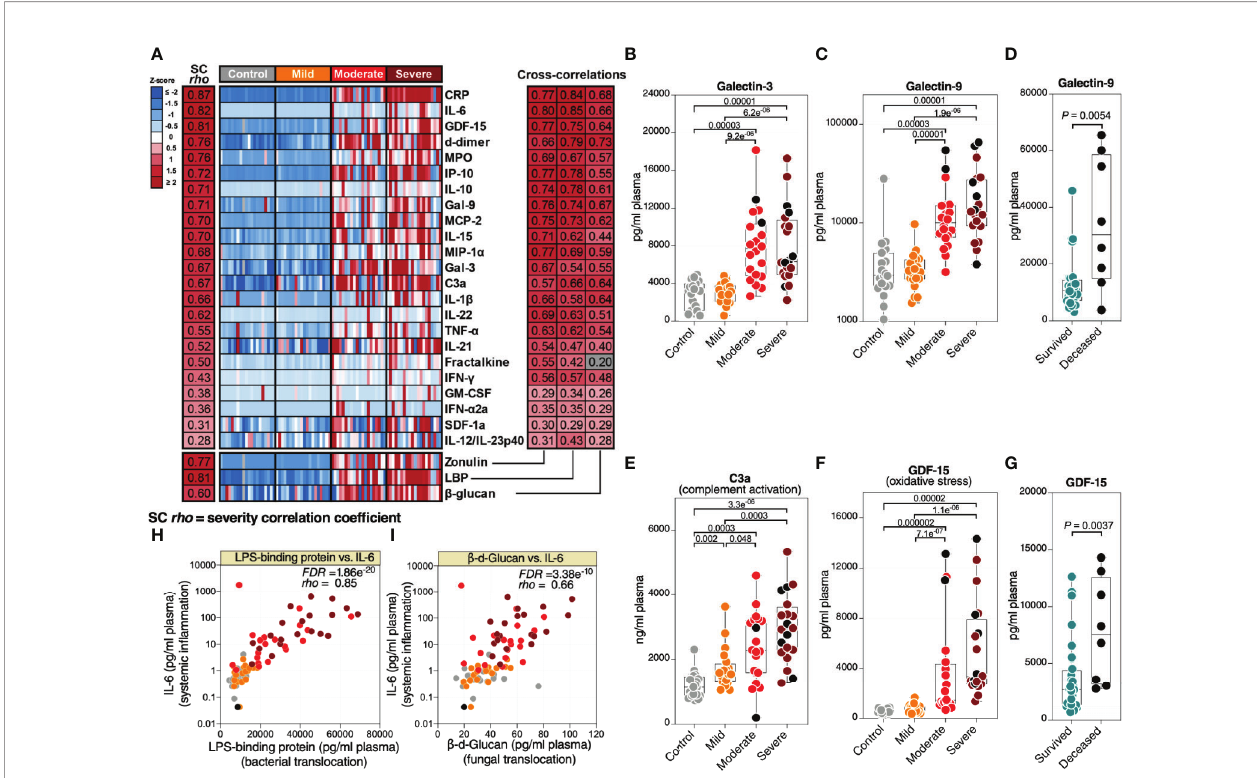
FIGURE 2 | Markers of tight junction permeability and microbial translocation are associated with markers of systemic in fl ammation. ( A left) Heat-map depicting plasma levels of 23 in fl ammation and immune activation/dysfunction markers whose levels are statistically (FDR<0.05) different between the four disease states. Statistical signi fi cance was determined using the Kruskal – Wallis test. FDR was calculated using Benjamini-Hochberg method. SC rho = coef fi cient of correlation with COVID-19 severity. Heat colors show standardized Z-scores across samples; red indicates upregulation, and blue indicates downregulation. ( A right) Coef fi cients of correlation between zonulin, LBP, or b -Glucan and each of the 23 in fl ammation and immune activation/dysfunction markers. All red-colored correlations had statistical signi fi cance of FDR<0.05, whereas the grey-colored correlation was non-signi fi cant. Correlations were evaluated using Spearman ’ s rank correlation tests, and FDR was calculated using the Benjamini-Hochberg method. (B – D) Levels of representative variables, galectin-3 (Gal-3) (B) and galectin-9 (Gal-9) (C) , were higher during severe COVID-19 compared to mild COVID-19 or controls, with levels of Gal-9 higher among deceased hospitalized patients compared to survivors (D) . (E – G) Levels of C3a (E) and GDF-15 (F) were higher during severe COVID-19 compared to mild COVID-19 or controls, with levels of GDF-15 higher among deceased hospitalized patients compared to survivors (G) . Kruskal – Wallis and Mann-Whitney tests were used for statistical analysis. FDR was calculated using Benjamini-Hochberg method. (H, I) Examples of correlations in (A) between LBP and IL-6 (H) or b -Glucan and IL-6 (I) . Spearman ’ s rank correlation tests were used for statistical analysis. Black dots indicate